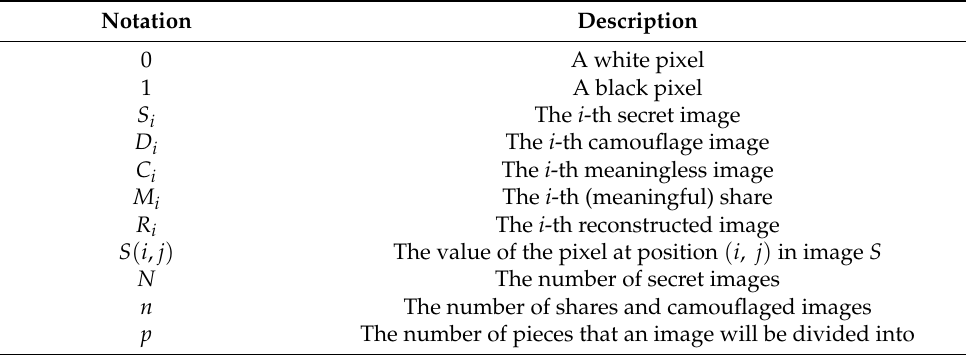
Table 1. Some symbols and parameters used in this